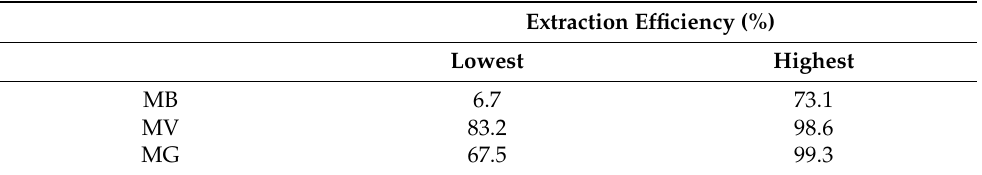
Table 1. Highest and lowest extraction efficiencies of the methylene blue (MB), methyl violet (MV), and malachite green (MG) dye solutions with the C12:C6 mixture at 24 h contact